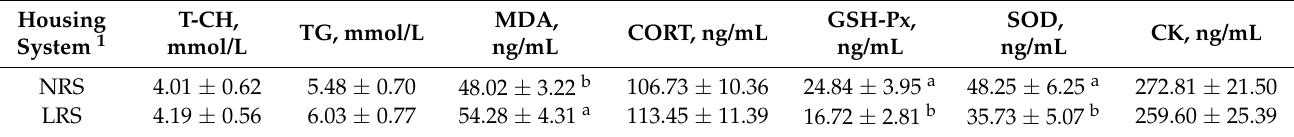
Table 2. Effects of two housing systems on blood serum parameters of hens from 32 to 40 weeks of age.